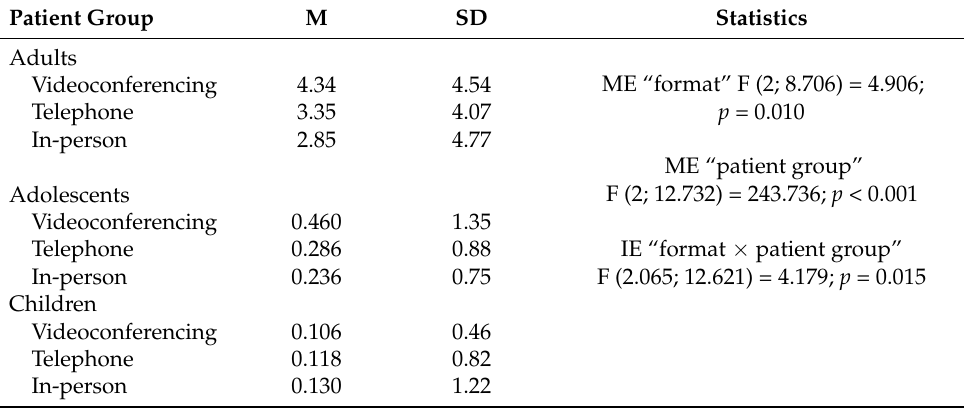
Table 3. Numbers of patients by treatment format during the COVID-19